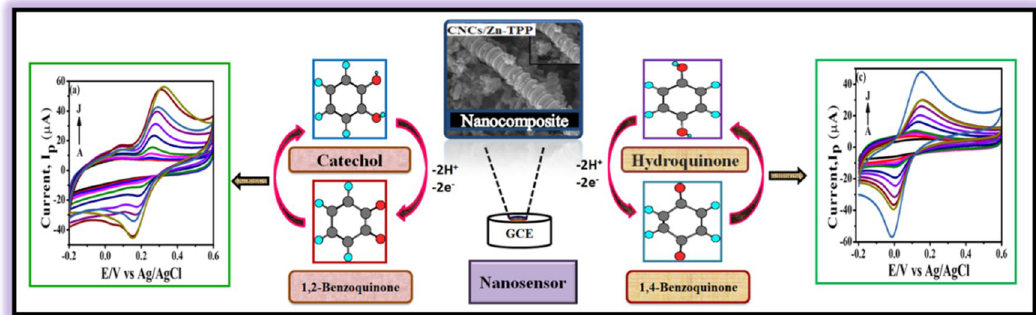
Figure 1. Graphical abstract representing fabrication of sensor and the detection of catechol and